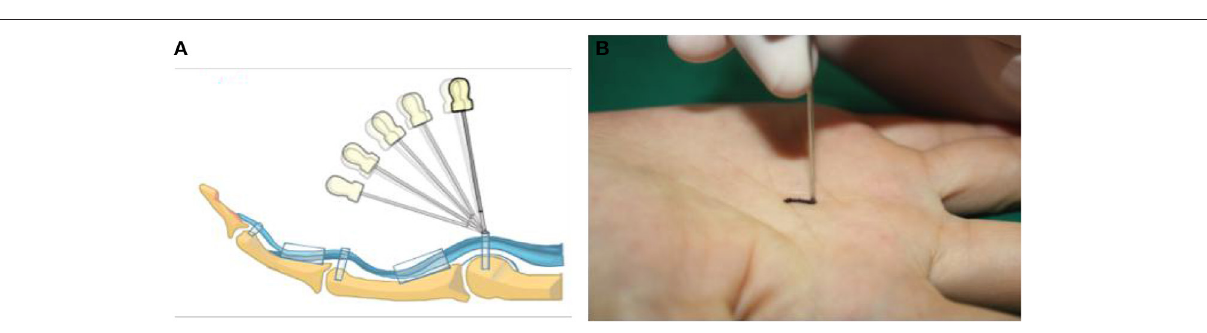
perpendicular to the skin surface. The blade-edge line is parallel to the imaginary line of flexor tendon sheath; (3) Stab: The tip of the needle knife was stabbed into the skin quickly, and then entered into sheath slowly and carefully. For an operator, if a break is felt, he should stop piercing further, and start to cut 1.0 ∼ 1.5 mm proximally. Meanwhile, the handle of the needle knife is slightly tilted distally, shifting from an angle of 90 ◦ to 60 ◦ to 30 ◦ on the skin surface ( Figure 4A ). The total forward cutting number is five to six. In backward direction, five to six cuts are performed again along the marking orientation (A1 parallel line of thumb or a connection line AD of finger). The group B were monitored by ultrasound during the whole procedure. The tip and body of the needle knife were parallel to the tendon (see Video 1 ) and ( Figures 6A,B